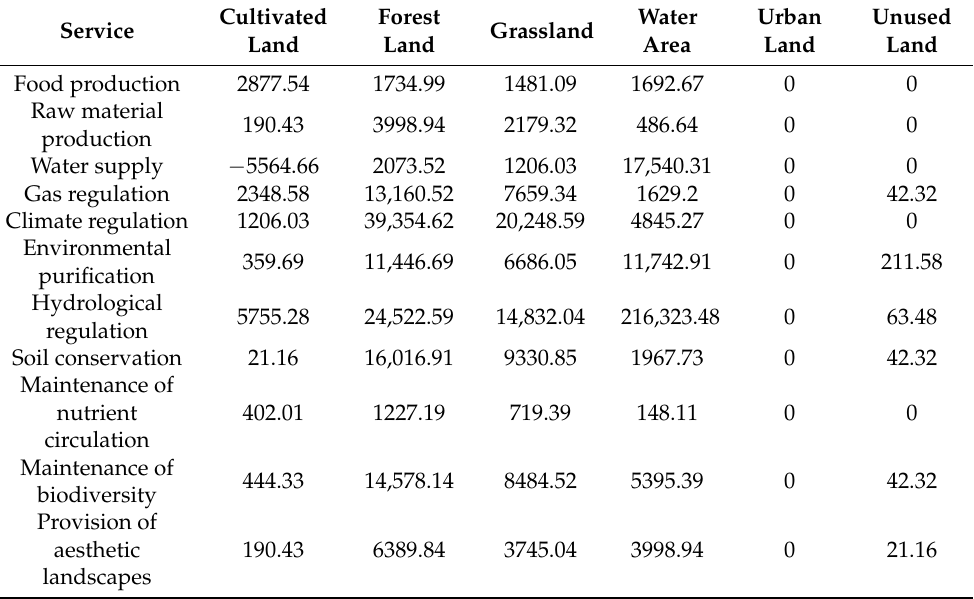
Table 3. The ESVs of the different ecological system unit areas in the GBA (CNY/hm 2 · a). Cultivated Service Land